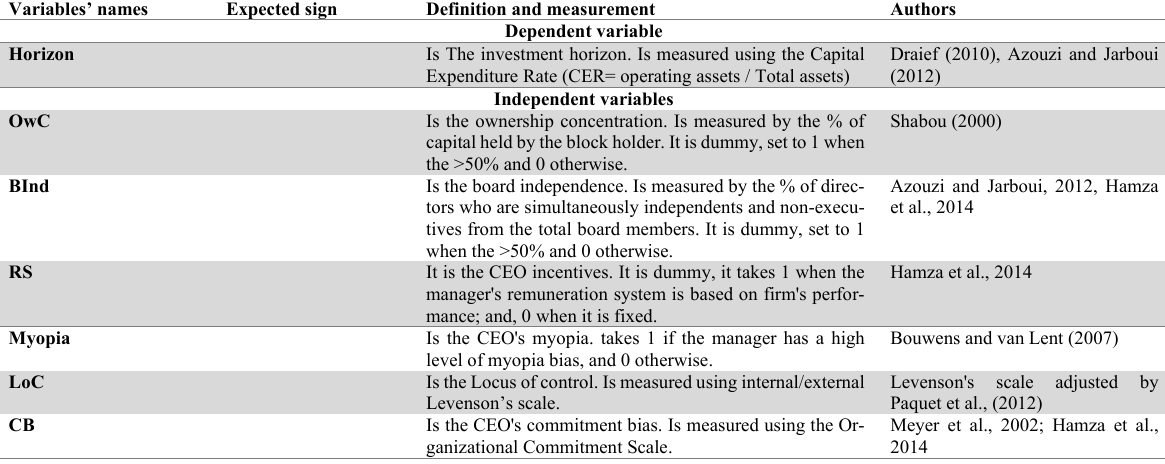
Table 1 Details of the dependent and independent variables of the two developed models Variables’ names Expected sign Definition and measurement Authors Horizon Is The investment horizon. Is measured using the Capital OwC Is the ownership concentration. Is measured by the % of